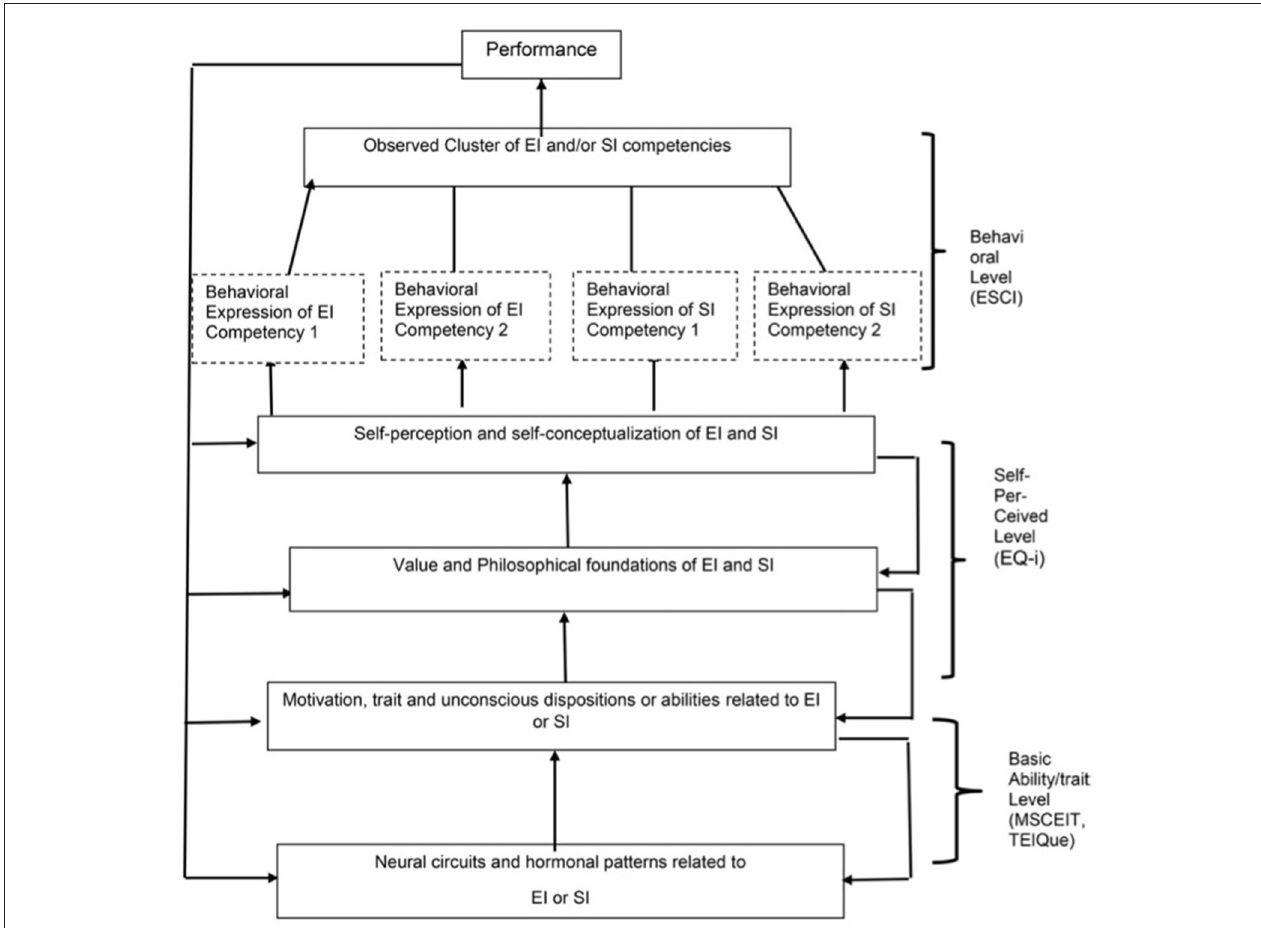
FIGURE 1 | Emotional intelligence (EI) as a multi-level theory [from Cherniss and Boyatzis (2013) which was adapted from Boyatzis (1982, 2009)].